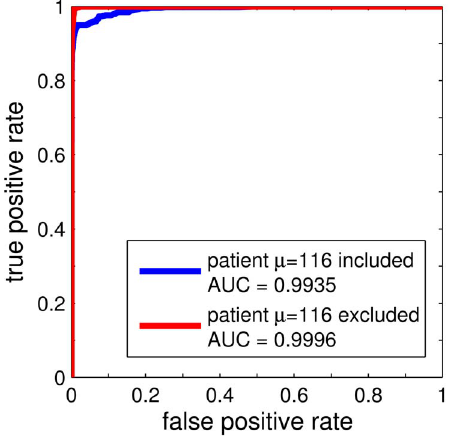
Figure 4. Validation set performance. Threshold-averaged ROC as obtained in the validation runs using labeled data. The curves correspond to using the data set including patient m ~ 116 (lower, blue line) and excluding patient m ~ 116 from the analysis completely (upper, red line), respectively.